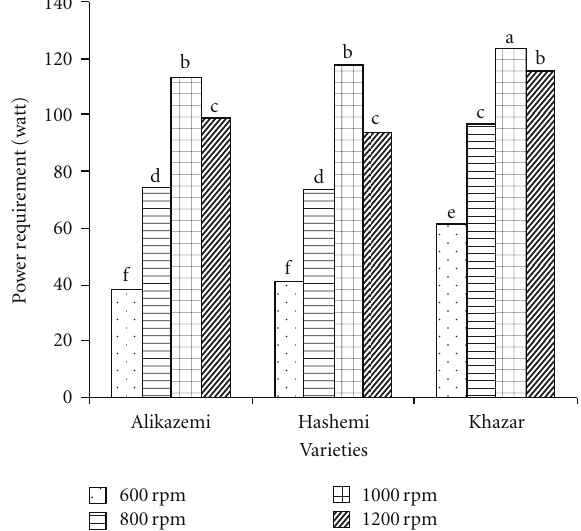
Figure 3: Mean comparison results of interaction e ff ects of variety and screw speed on power requirement (dissimilar letters show di ff erent significantly at probability level %5).